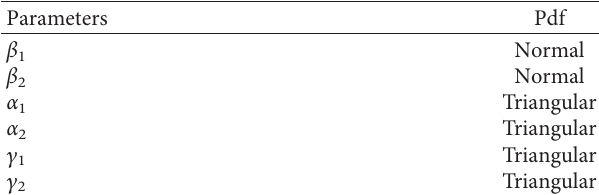
Figure 6: Examples of the steady state E simulated with initial conditions I ( 0 ) � 100 , A ( 0 ) � 100, and D ( 0 ) � 100 and parameters’ values ∗ from Table 3. (a) Example 11. (b) Example 12. Table 4: Six input parameters’ probability distribution